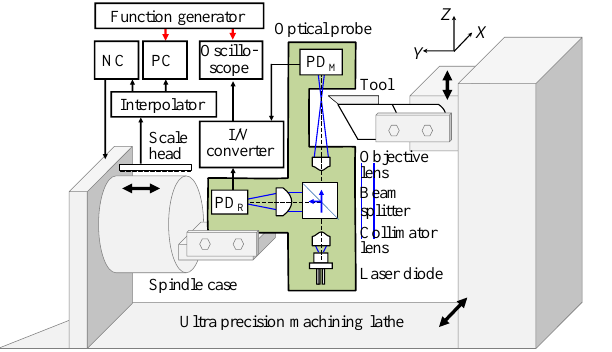
Figure 4. A schematic of the on-machine tool’s edge contour mea- surement